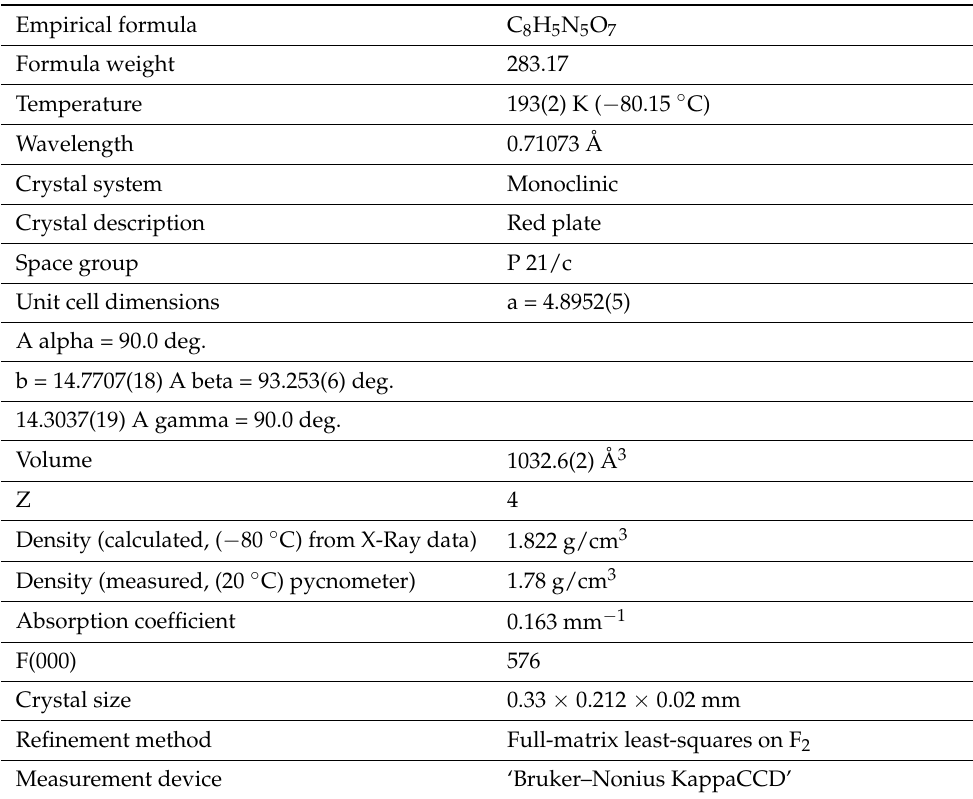
Figure 9. Ortep image at the 50% probability of thermal ellipsoids for 5-methyl-4,6,7-trinitro-1,3-dihydro- 2H -benzimidazol-2-one (5-Me-TriNBO, ( 2 ))—(crystal (red plate)) was obtained from the solution in nitromethane. Table 2. The main crystallographic data for 5-MeTriNBO ( 2 ).